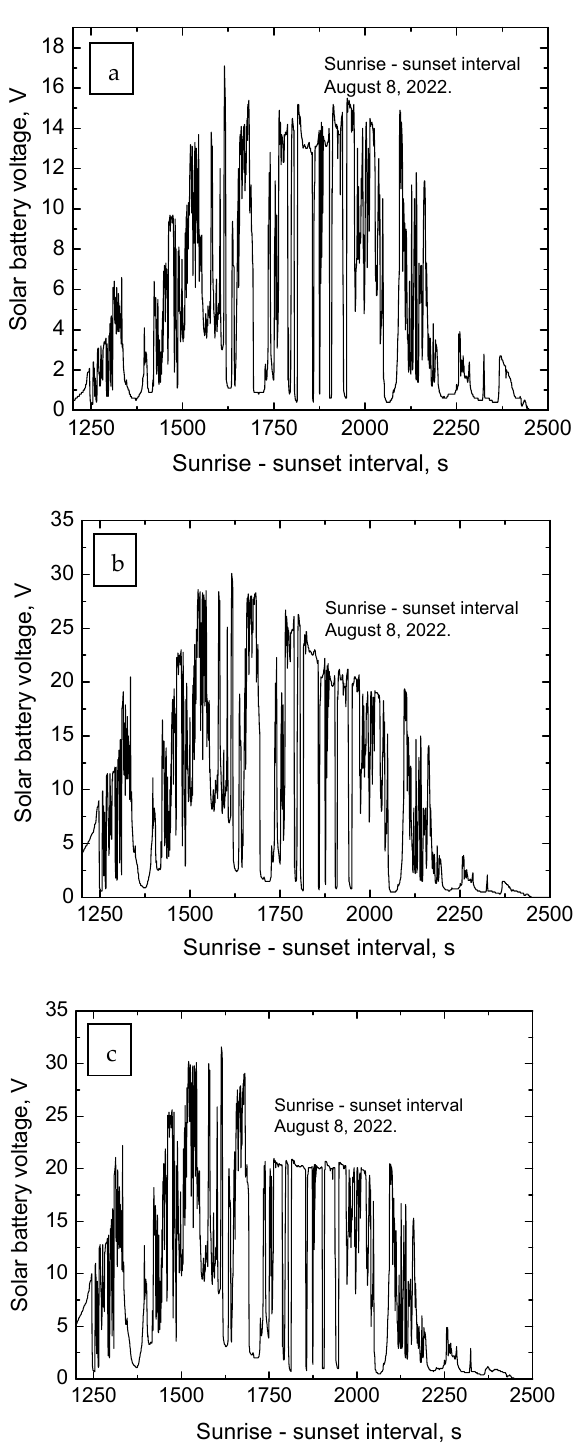
Figure 7. Dependence of solar battery (290 W) voltage on daylight interval: ( a ) battery used for 10 years; ( b ) new polycrystalline battery; ( c ) bifacial type battery.